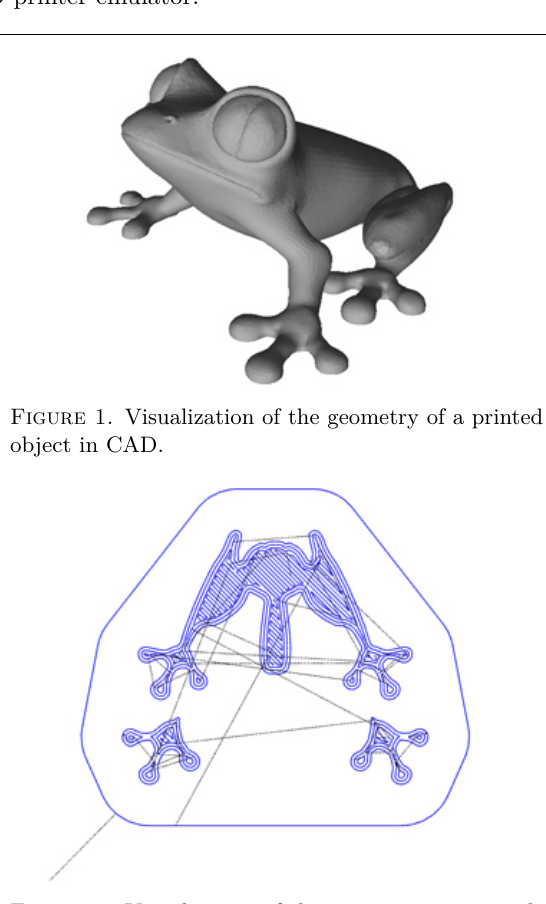
Figure 2. Visualization of the movement commands contained in the input file (single layer). Moves with material extrusion are drawn with blue color, moves without extrusion with black